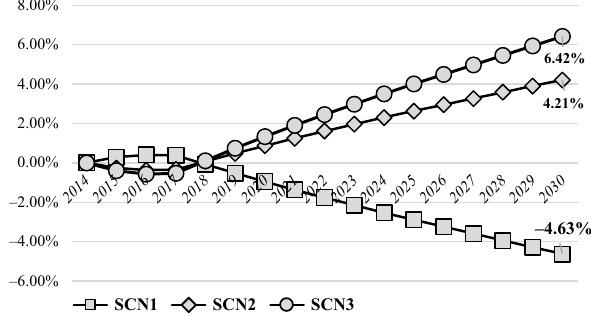
Figure 5. Differences of aggregated labor demand from the BAU (%)